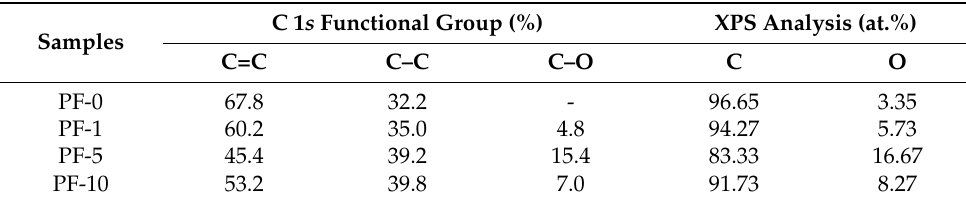
Figure 2. C 1 s XPS spectrum of different PIM-derived pitch fibers: ( a ) PF-0; ( b ) PF-1; ( c ) PF-5; ( d ) PF- 10. ( d ) PF-10. Table 1. XPS Results of Different PIM-Derived Pitch